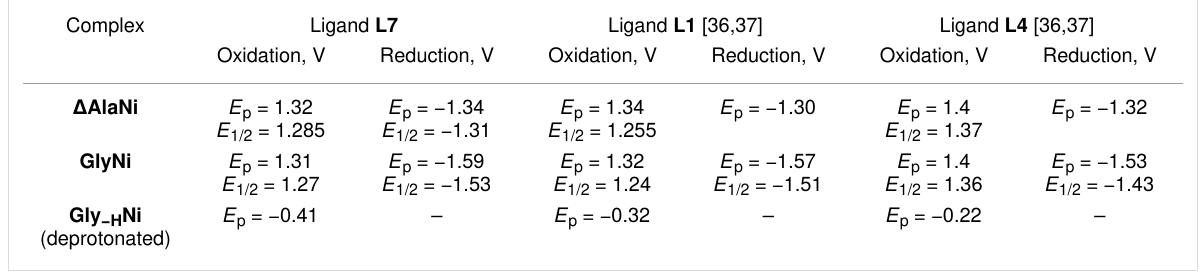
Table 4: Oxidation and reduction potential values for ( GlyNi ) L7 and ( Δ AlaNi ) L7 and comparison with previously reported data for ( GlyNi ) L1 , ( Δ AlaNi ) L1 , ( GlyNi ) L4 and ( Δ AlaNi ) L4 [36,37] (Pt, CH 3 CN, 0.1 M Bu 4 NBF 4 , vs Ag/AgCl/KCl (sat.) , 100 mV/s). Complex